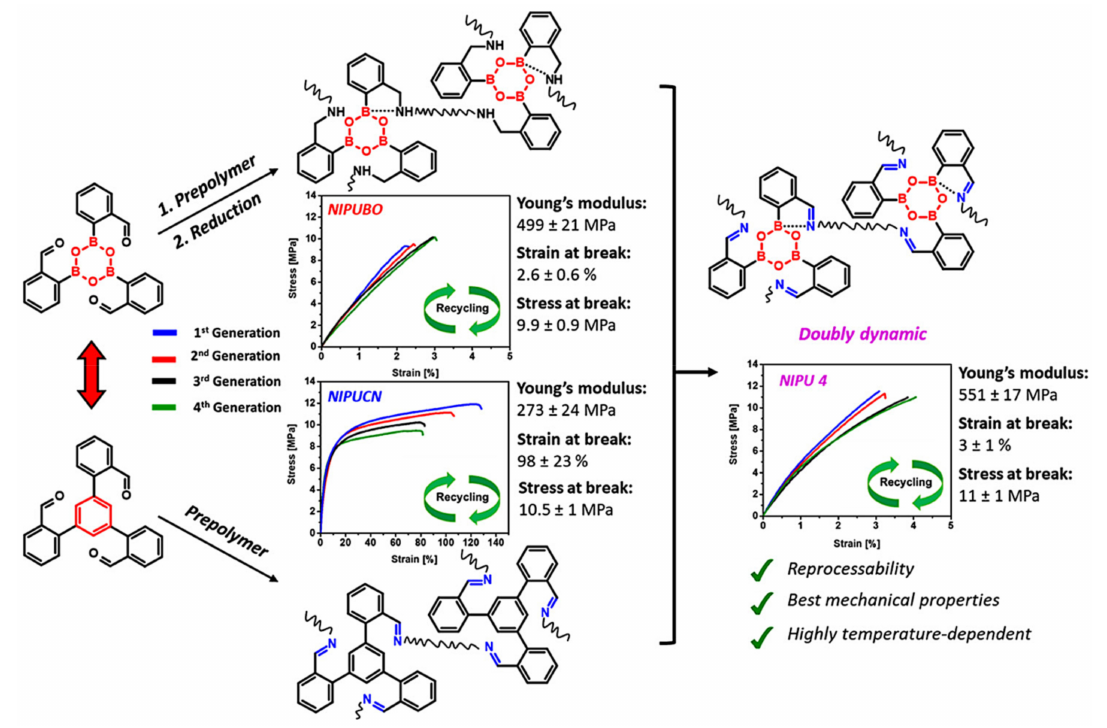
Figure 9. The comparison of mechanical properties of the single- and double-dynamic networks over. C=N imine and B − O boroxine bonds are both shown to be responsible for the remendability of their networks (NIPUBO and NIPUCN). B − O bonds appear to have a predominant effect on the mechanical and recyclable properties of NIPU 4. The double-responsive network is shown to possess the best mechanical performance because of the combination between boroxine and iminoboronate chemistry. Reprinted with permission from Reference [116]. Copyright (2019) American Chemical